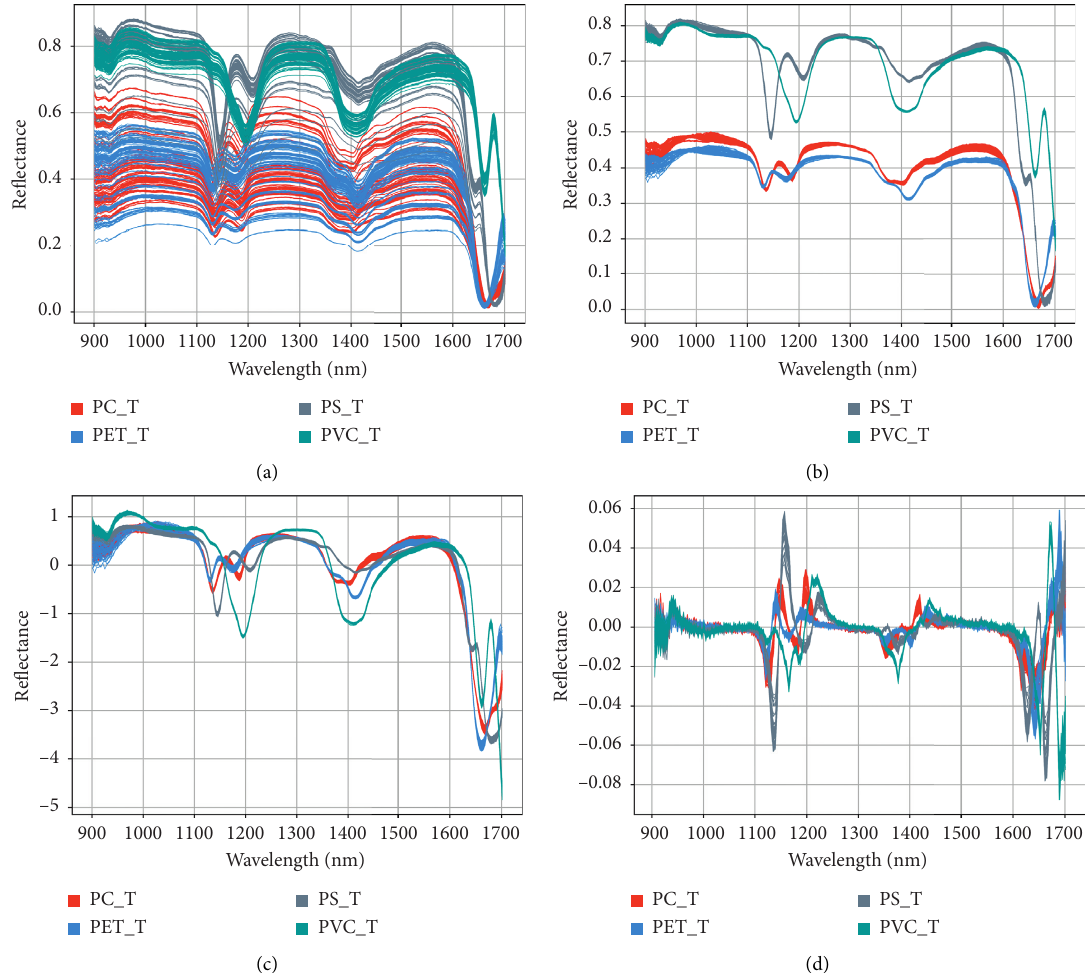
Figure 1: NIR spectra of transparent commercial plastic. (a) Raw, (b) MSC, (c) SNV, and (d) first-order derivative.